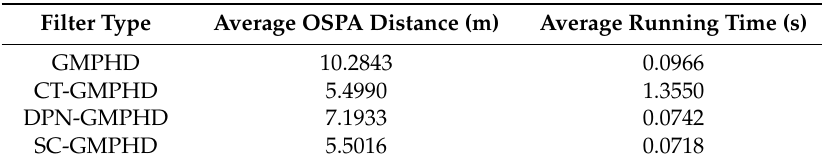
Table 5. Average OSPA distance and running time of the different filters with different clutter rates when the detection probability is equal to